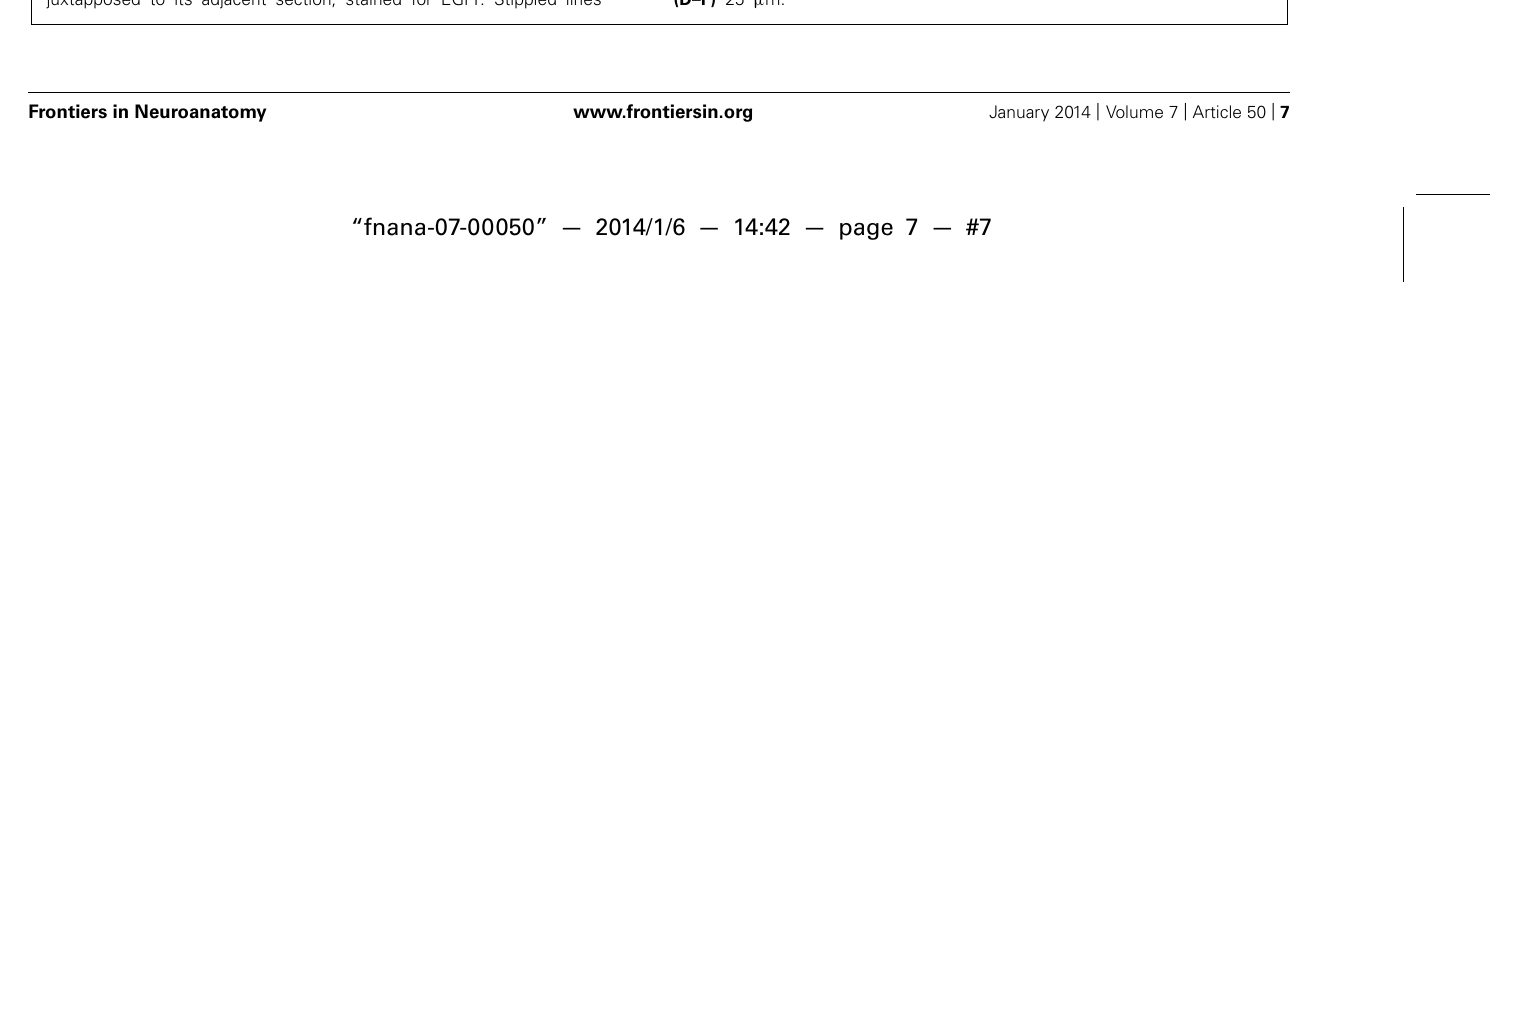
FIGURE 5 | EGFP decorates presynaptic terminals in the spinal cord of Emx1 - Cre Rosa26 EGFP-VAMP2/ + mice and colocalizes with synaptotagmin 1 positive puncta. Transverse sections of the spinal cord at cervical (A) , sacral (B) , and lumbar (C) levels. In (A) , strong signal is seen in the dorsal white matter (arrows; see text for discussion). In (C) , a Nissl-stained lumbar cord hemisection is juxtapposed to its adjacent section, stained for EGFP. Stippled lines